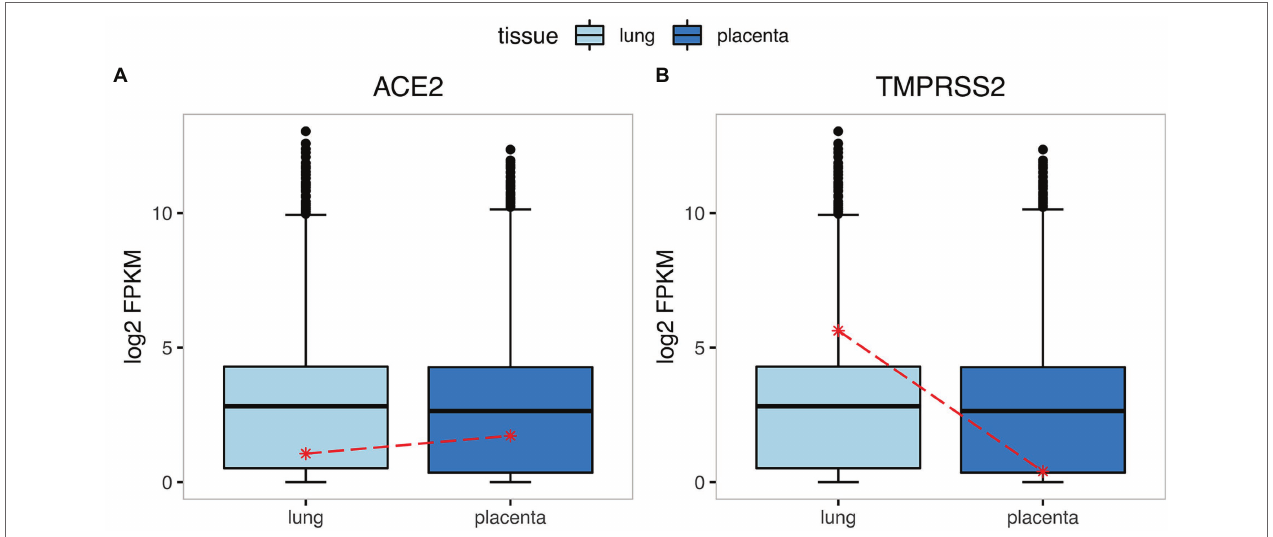
FIGURE 2 | The expression of the SARS-CoV-2 infection-associated factors in the lung and placenta. The boxplot represents the expression level of ACE2 (A) and TMPRSS2 (B) in the lung and placenta, the asterisk marks the mean expression level of genes. The y-axis indicates the normalized expression (log2-transformed FPKM + 1) of